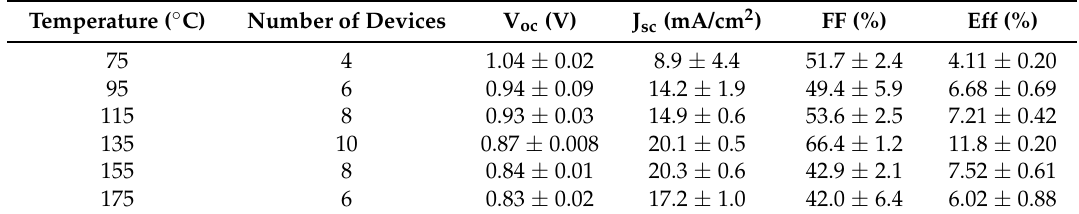
Table 2. Parameters of solar cells based on perovskite (FAPbI 3 ) 1 − x (MAPbBr 3 ) x film annealed at various temperatures based on at least four devices.